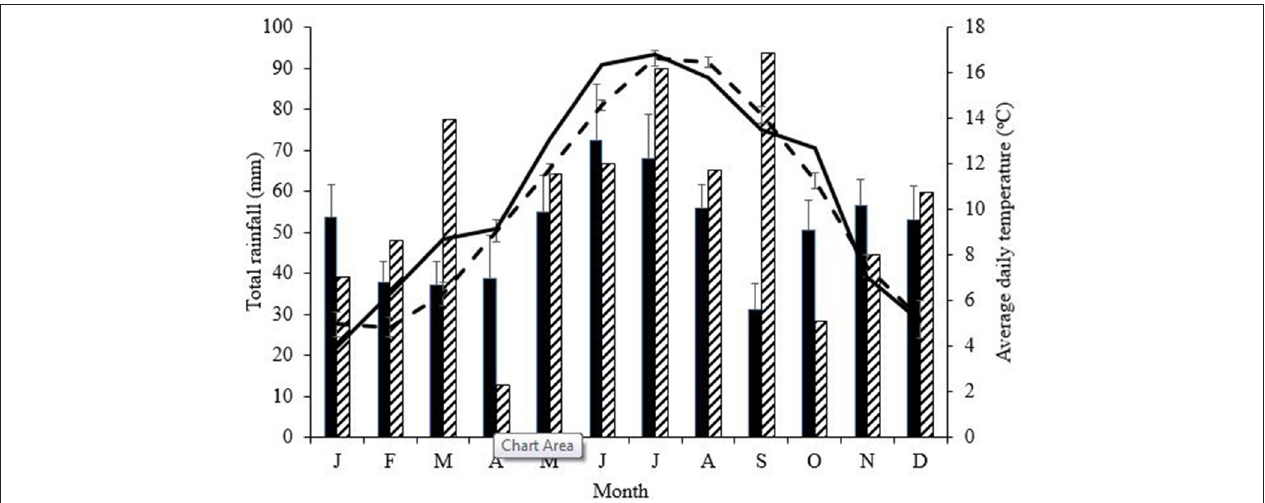
FIGURE 1 | Total rainfall and average daily temperatures for the months January to December during the years 2007 to 2016 (solid column and line respectively) and during the study year of 2017 (dashed column and line respectively). Standard error bars are ahown for months during years 2007 to